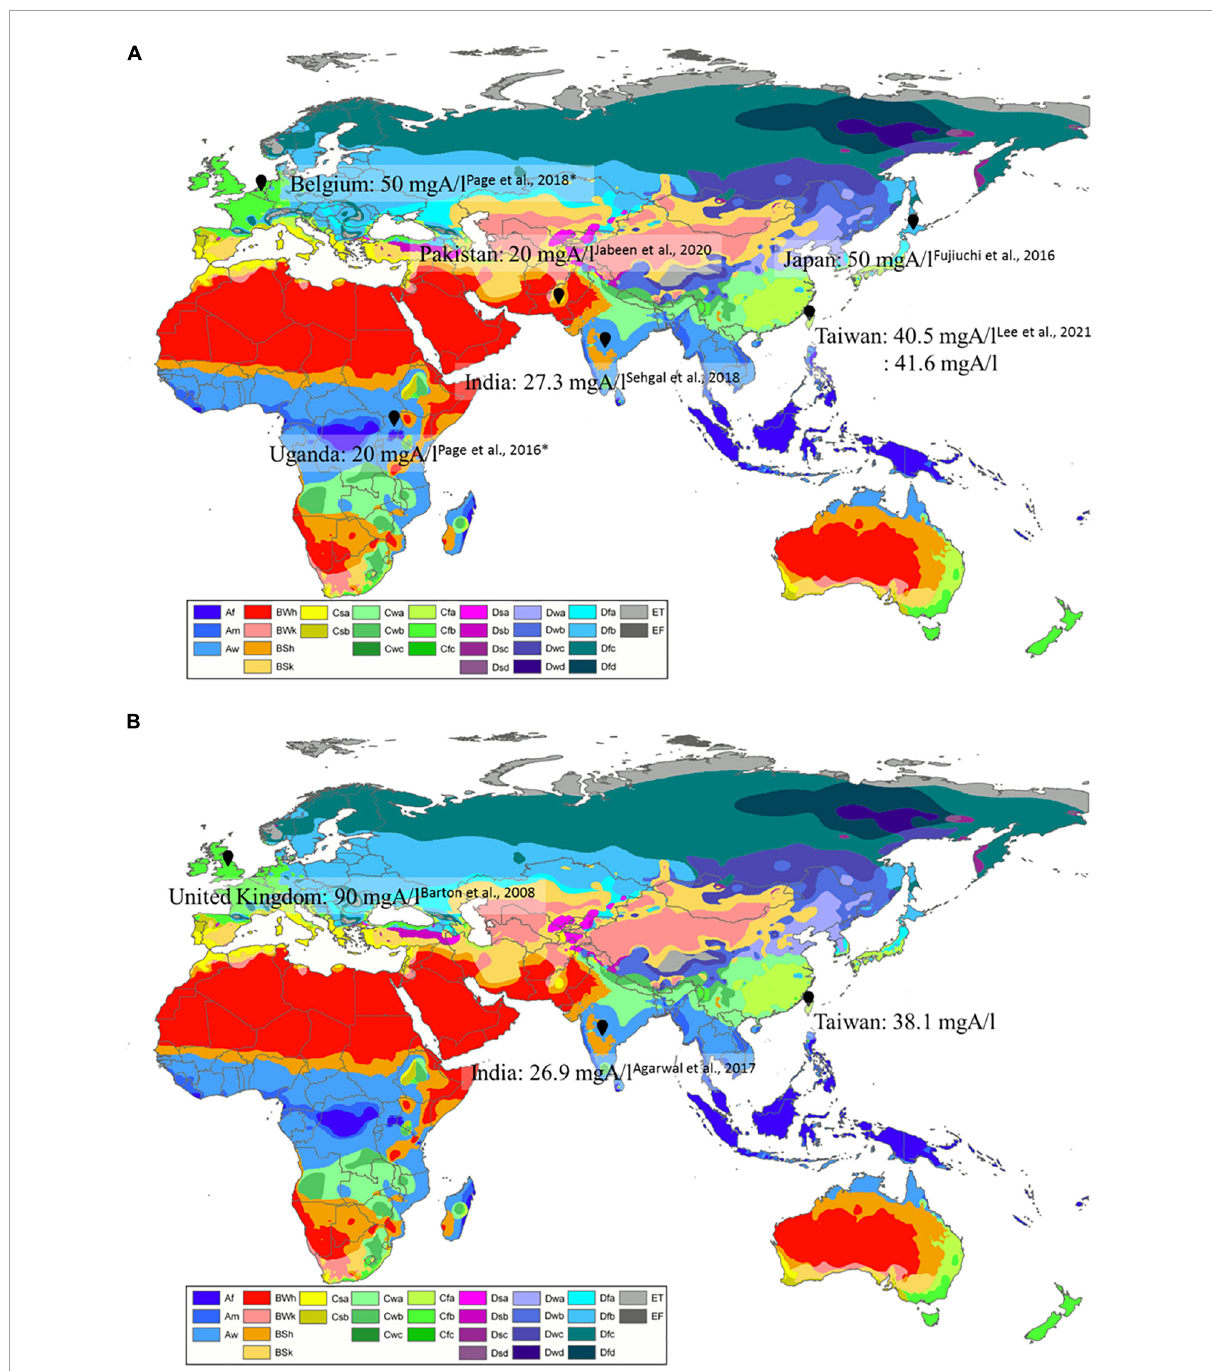
FIGURE2 Geographic differences of (A) Aspergillus fumigatus -specific IgG cut-off levels in patients with CPA, (B) A. fumigatus -specific IgG cut-off levels in patients with ABPA by eco-climatic zones. CPA, chronic pulmonary aspergillosis; ABPA, allergic bronchopulmonary aspergillosis. *Cases from the United Kingdom. Created with updated world map of the Köppen–Geiger climate classification (Peel et al., 2007). Description of Köppen climate symbols ( Supplementary Table 1 ).